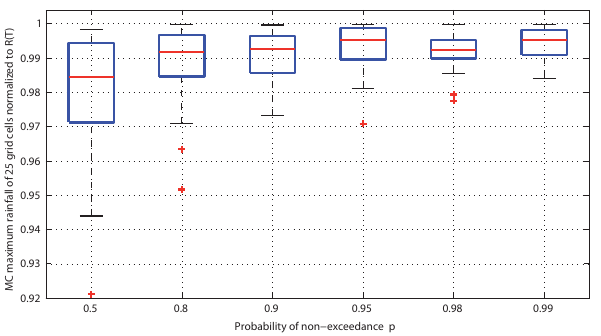
Figure 11. Estimation of the bias introduced by the assumptions taken for the synthetic rainstorm events and the random location of the storm centres in the Monte Carlo analysis. For each probability level the maximum of the 140 synthetic storm events was extracted for 25 grid cells evenly spaced over the simulation domain. The maximum rainfall was normalized to the value given by the gener- alized Pareto distribution fitted to the POT rainfall series. A value of 1 thus indicates zero bias. The box plots show the distribution of the maximum rainfall among the 25 grid